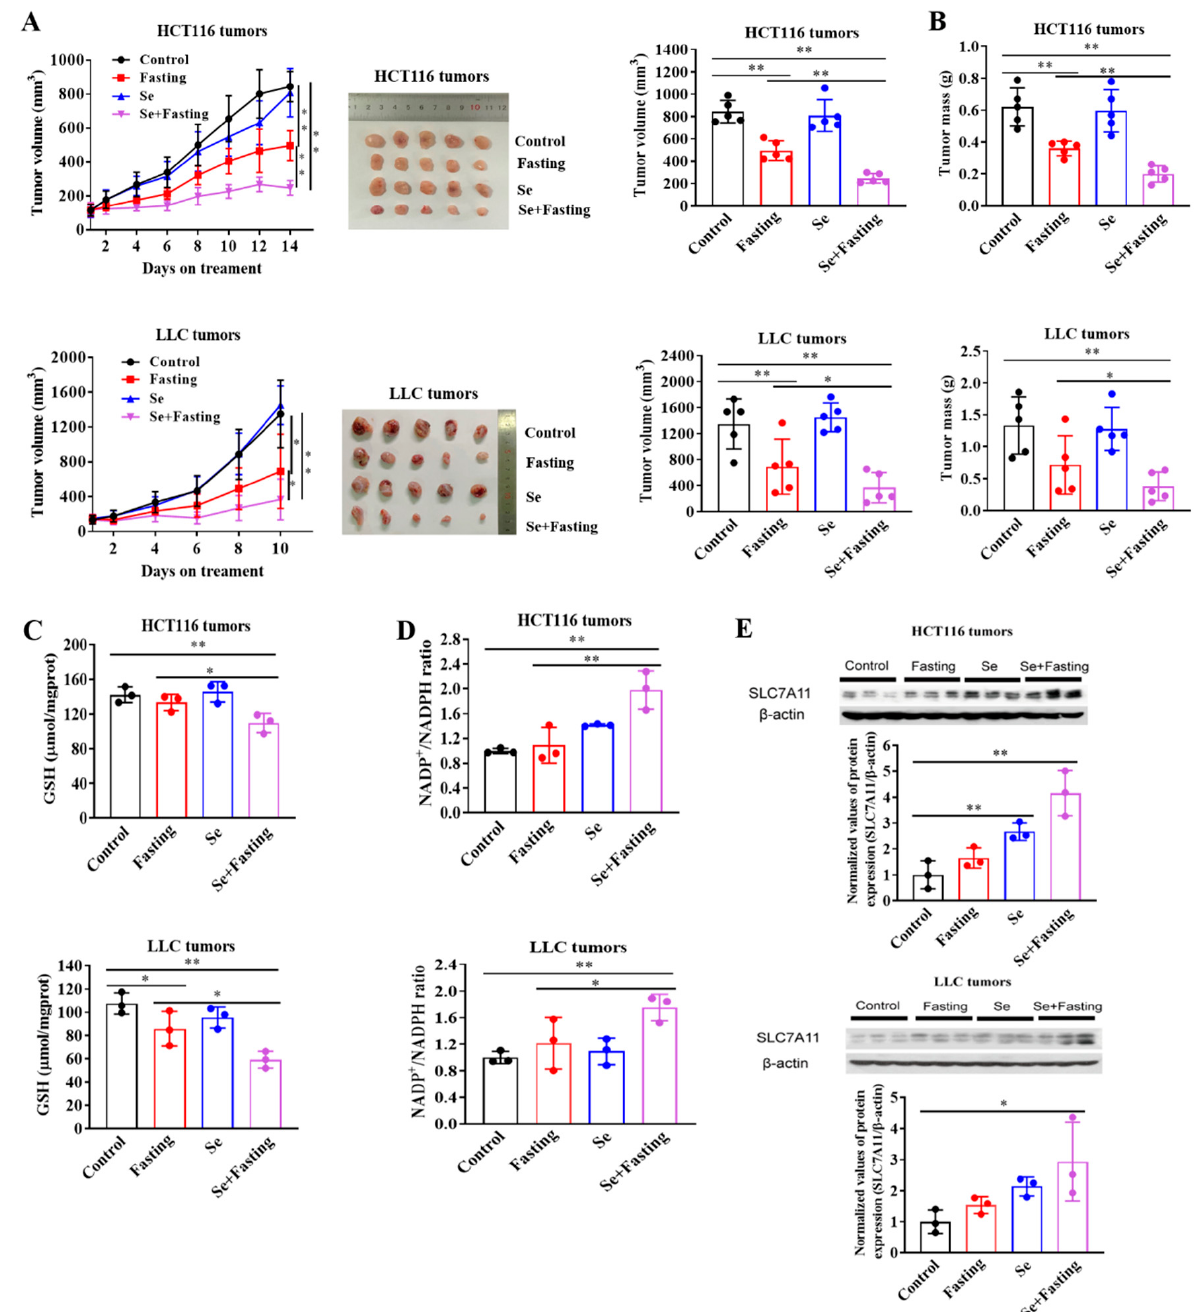
Figure 6. Fasting improves therapeutic efficacy of selenite in vivo. ( A ) In vivo growth of tumors as measured by tumor volume in mice inoculated with HCT116 cells or LLC cells; picture and volume of tumors isolated from mice in different groups. ( B ) Weight of tumors isolated from mice in different groups. ( C – E ) Measurement of GSH levels ( C ), NADP+/NADPH ratios ( D ) and SLC7A11 protein levels ( E ) of tumors isolated from mice in different groups. Data are expressed as mean ± SD, * p < 0.05, ** p < 0.01. Control: control group, mice were fed ad libitum and treated with water; Fasting: fasting group, mice experienced feeding/fasting cycles for 24 h, respectively; Se: selenite group, mice were fed ad libitum and treated with 2 mg/kg body weight of selenite during fasting cycle; Se + Fasting: selenite-hypoglycemia combination group, mice experienced feeding/fasting cycles for 24 h, respectively and were treated with 2 mg/kg body weight of selenite during fasting cycle, n = 5 per